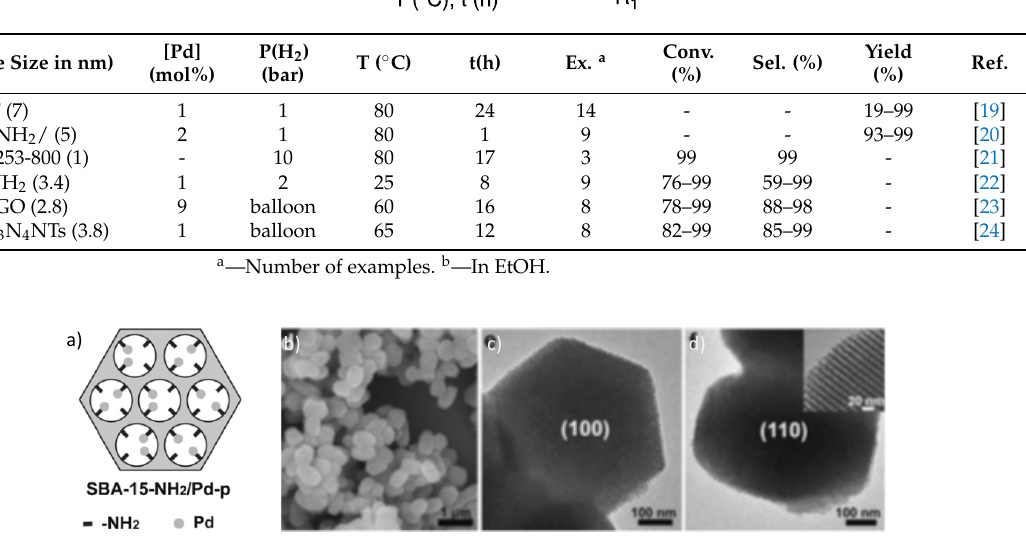
Figure 1. PdNPs anchored to amino-functionalized mesoporous silica ( a ), SEM image of SBA-15- NH 2 /Pd–p ( b ), and TEM images of the hexagonal platelet morphology (( c ) and ( d )). Inset in ( d ) shows high-magnification image [20]. Reproduced from [20] with permission from Wiley.